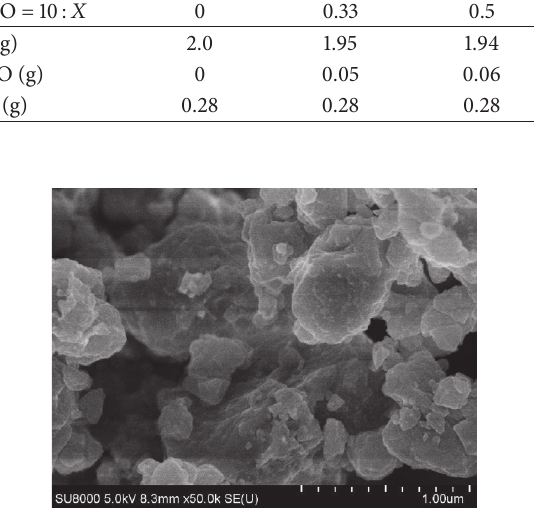
Figure 2: SEM image of microscale composite particles formed by grinding Si, H 2 O, and Cu.